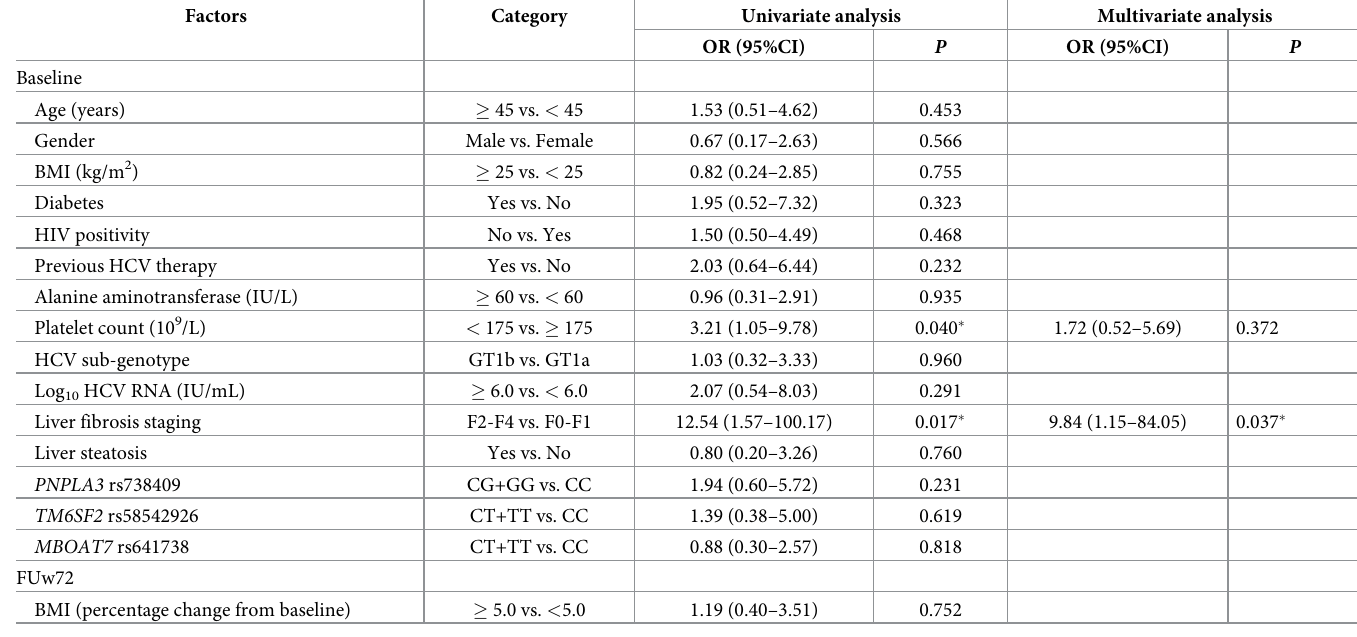
Table 2. Factors associated with MRE reduction ( � 30% from baseline).